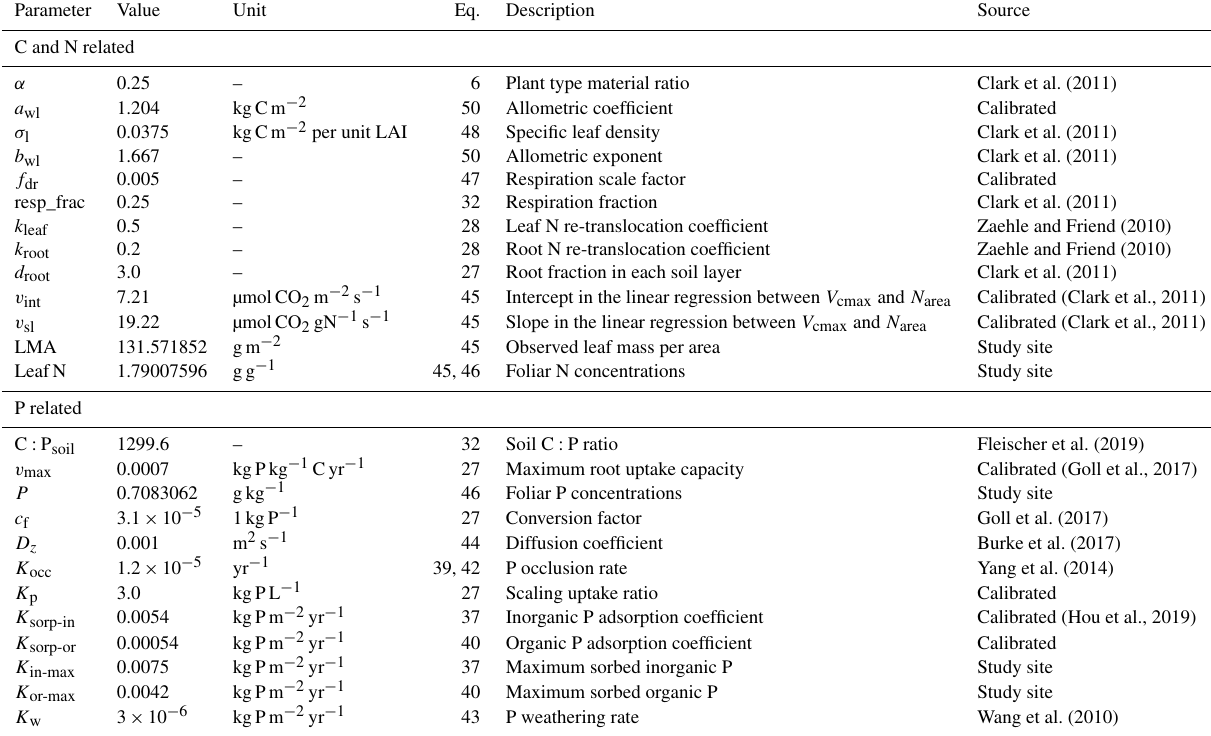
Table 2. P model